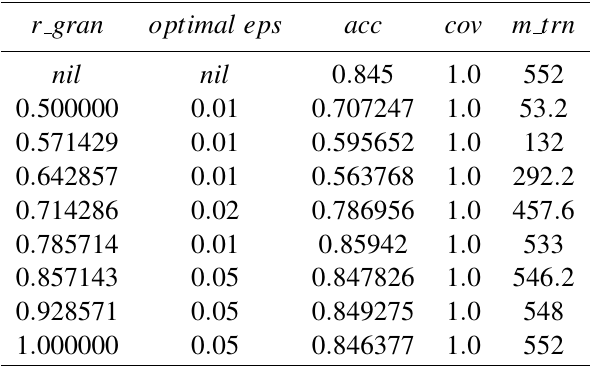
CV-5; Australian credit; Algorithm 7 v3. r gran=granulation radius, optimal eps= optimal epsilon, acc=Total accuracy, cov=Total coverage, m trn=mean training